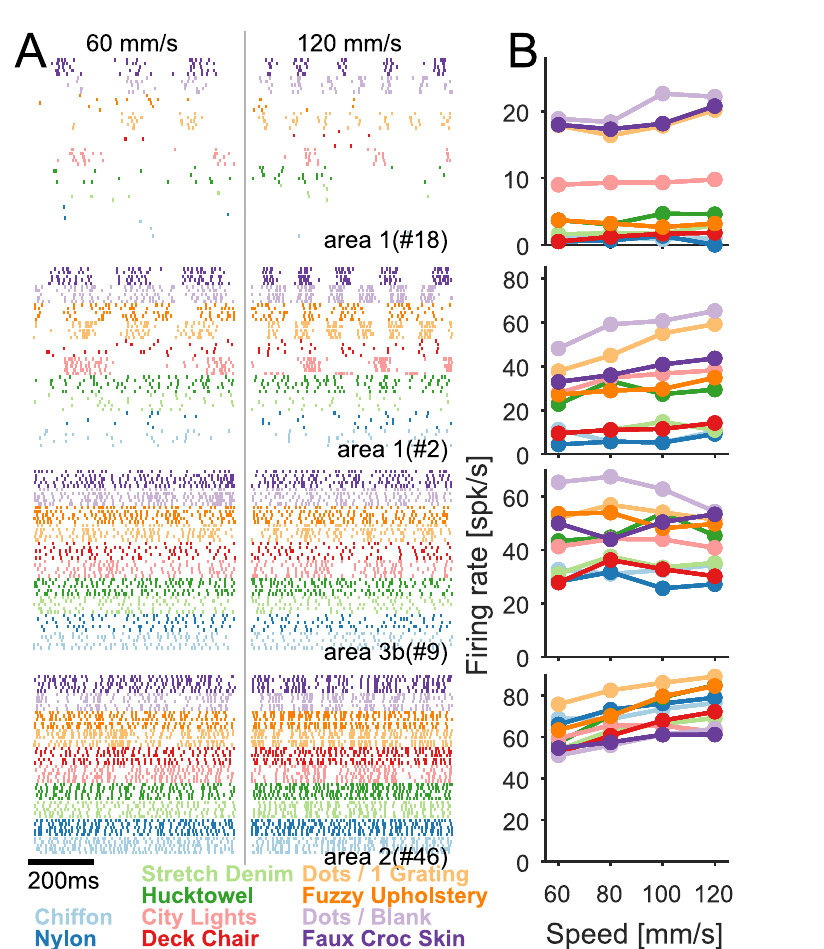
Fig 6. Speed dependence of the responses of cortical neurons. (A) Spiking responses of four neurons in somatosensory cortex to five repeated presentations of 10 different textures scanned over the center of their RFs at two different speeds. Neurons #2 and #46 increase their rate with speed; neurons #18 and #9 do not. (B) Mean firing rate versus speed. Each color denotes a different texture (see legend at the bottom left). Data underlying this figure can be found in S1 Data. spk,